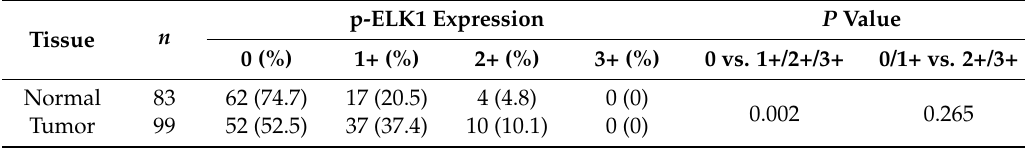
Table 1. p-ELK1 expression in non-neoplastic urothelium versus urothelial neoplasm tissue specimens.